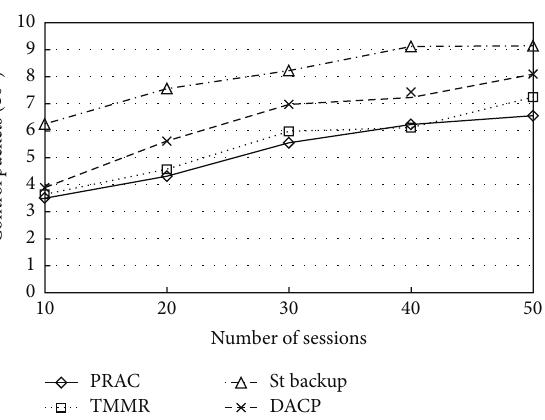
Figure 6: End to end delay.